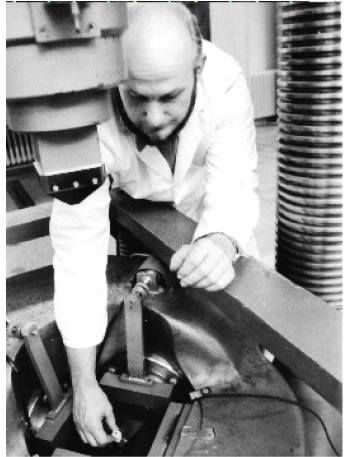
Figure 6. Sample insertion at the triaxial